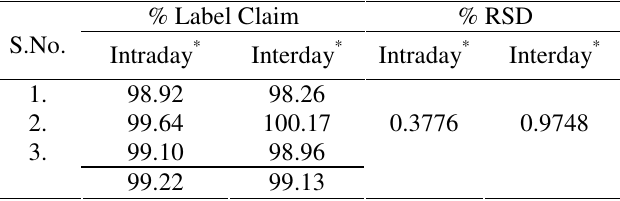
Table 3. Intraday and Interday analysis of formulation.